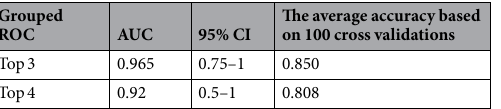
Grouped ROC AUC 95% CI Top 3 0.965